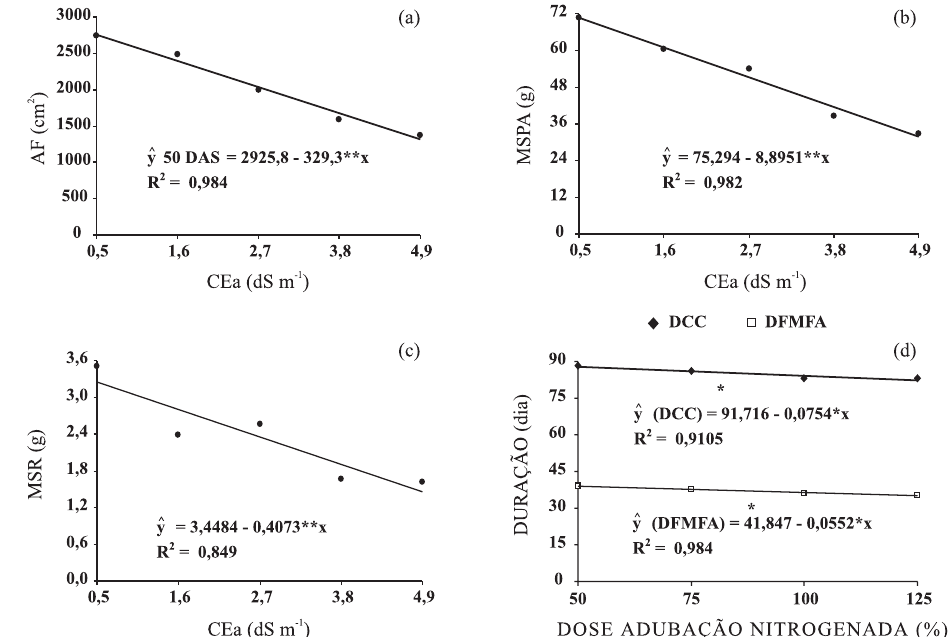
Figura 1. Área foliar - AF aos 50 dias após semeadura (a) e matéria seca da parte aérea - MSPA (b) e de raiz - MSR (c) na época da colheita, em função da condutividade elétrica da água de irrigação (CEa) e duração do ciclo da cultura - DCC e da formação até a maturação fisiológica dos aquênios – DFMFA (d), em função de doses de adubação